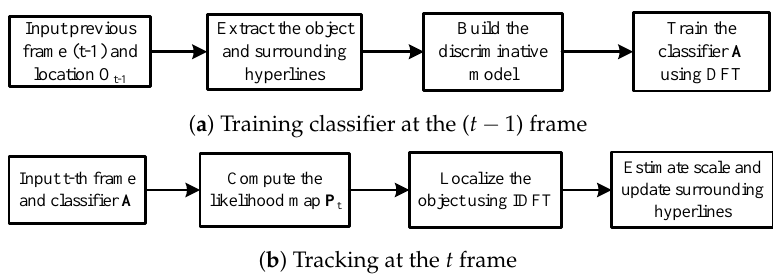
Figure 1. Main components of the proposed hyperline clustering-based tracker